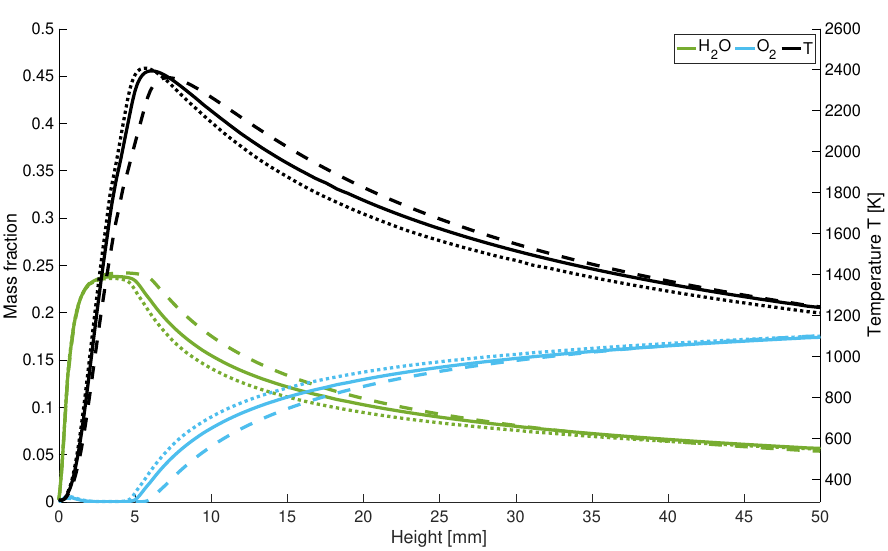
Figure 7. Temperature and mass fraction for different λ ; solid line: λ = 1.5; dotted lines: λ = 2 ; dashed lines: λ = 1.